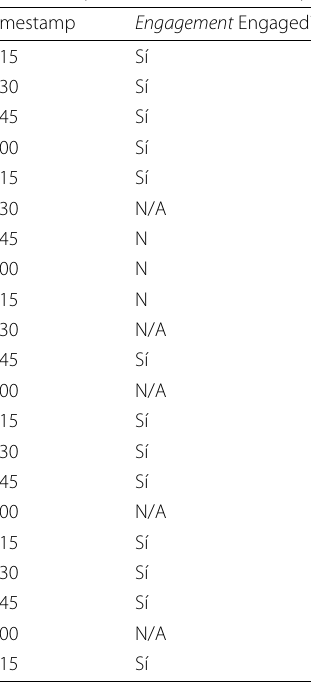
Table 6 Experiment: Results from speech